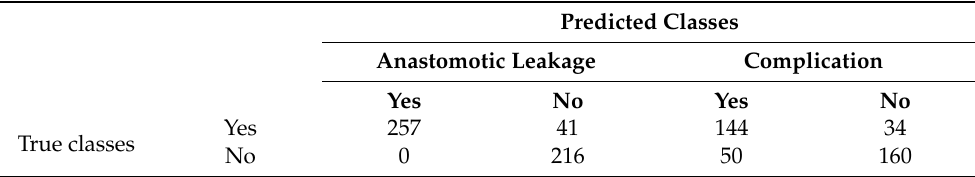
Table 7. The confusion matrix of predicted and true postoperative outcomes after colorectal cancer surgery in the MLP